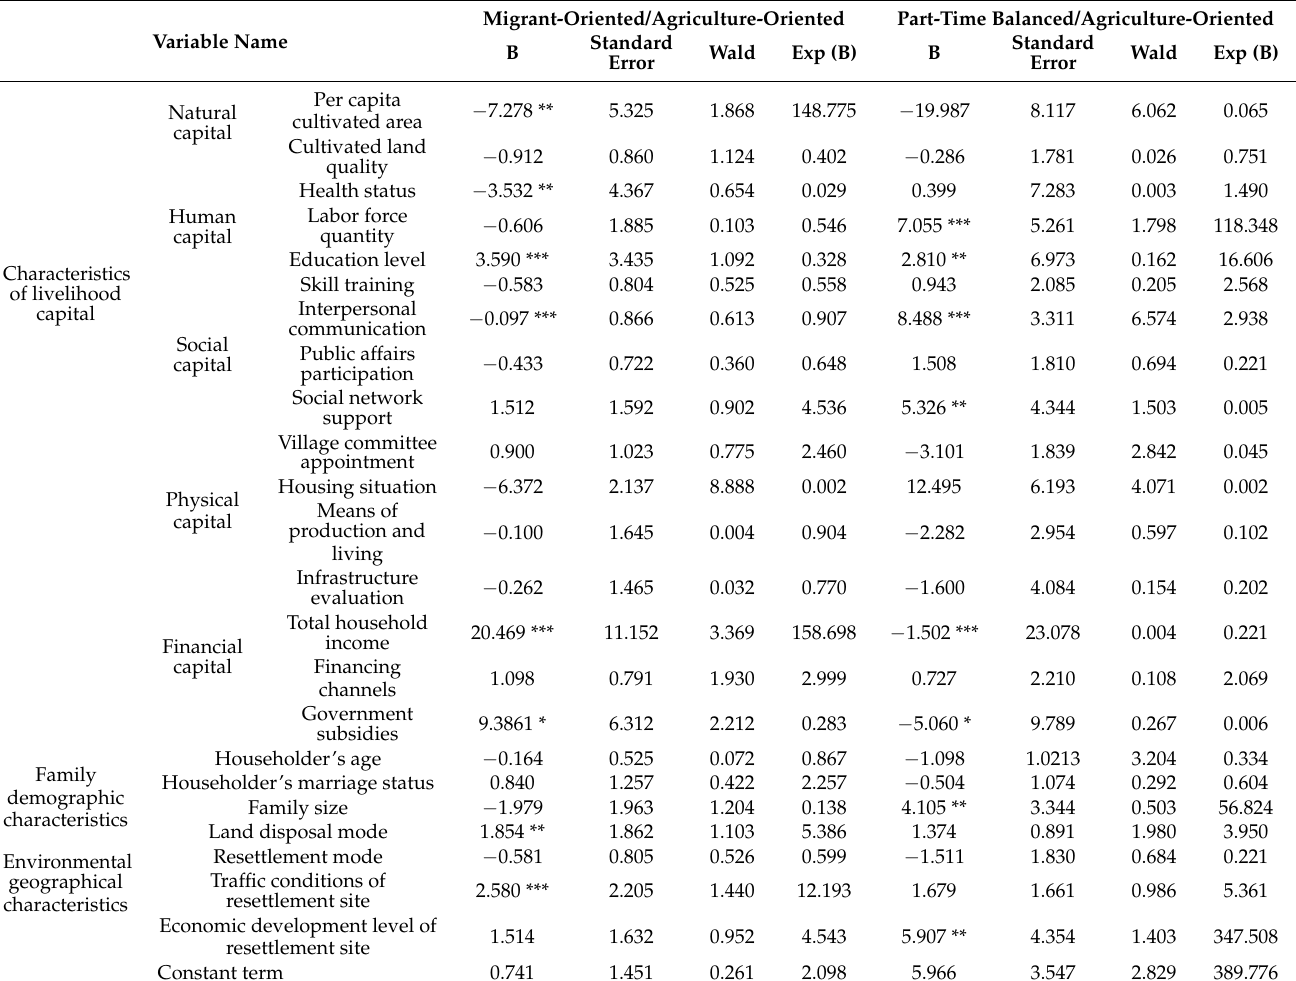
Table 8. Regression results of the impact of livelihood capital subdivision variables on livelihood strategy